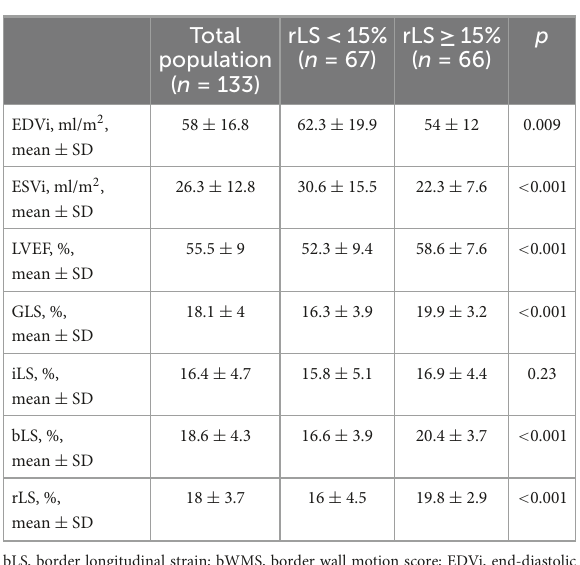
TABLE 4 Differences in follow-up data between patients stratified by median values of rLS at